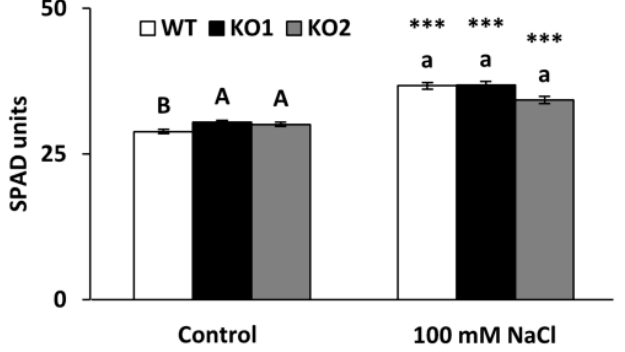
Figure 4. Total chlorophyll content in A. thaliana wild type (WT) and two KO Attrxo1 mutant lines grown in the absence (Control) and presence of 100 mM of NaCl. Data in SPAD units are mean ± standard error of at least eight independent experiments. Different letters indicate significant differences ( p < 0.05) among genotypes in each condition according to the Tukey’s test, and the asterisks indicate significant differences of each genotype in salinity compared to the control condition using the t -Student’s test ( p <